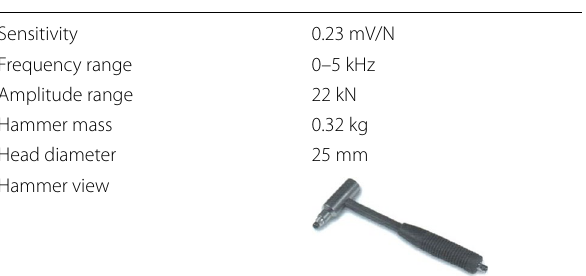
Table 2 Accelerometer and impact hammer.